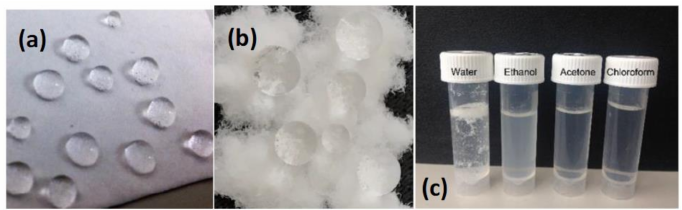
Figure 6. Photos of water drop on the surface of dried esterified cellulose samples: ( a ) Film of N10T80t1; ( b ) N10T60t2. ( c ) A photo shows redispersion of PeM-CNP-S05T80t2 in water, ethanol, acetone, and